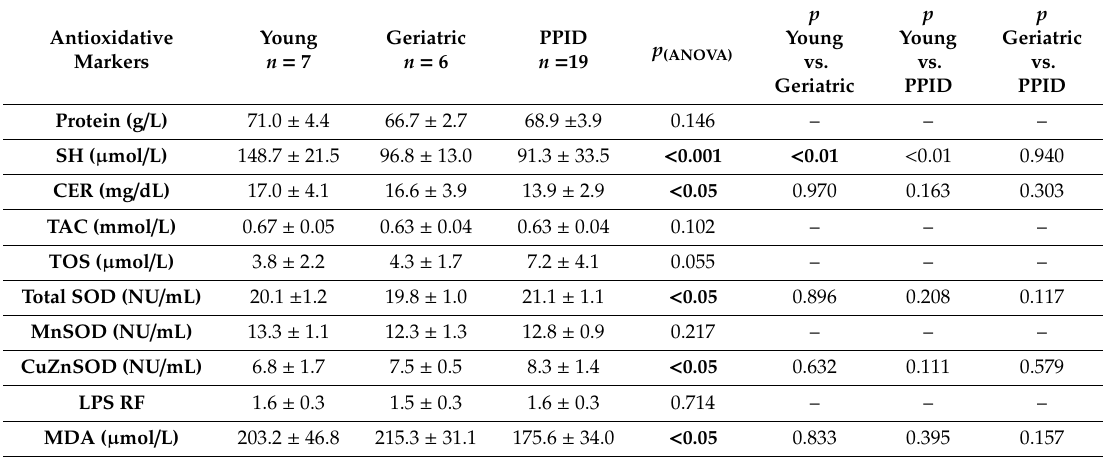
Table 2. Comparison of selected antioxidative markers between control, geriatric and PPID groups. Antioxidative